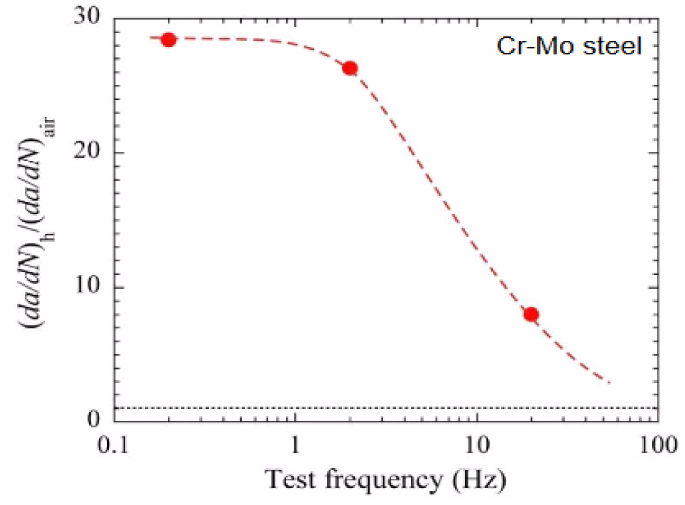
Figure 8. Influence of frequency on the crack growth rate, hydrogen tests